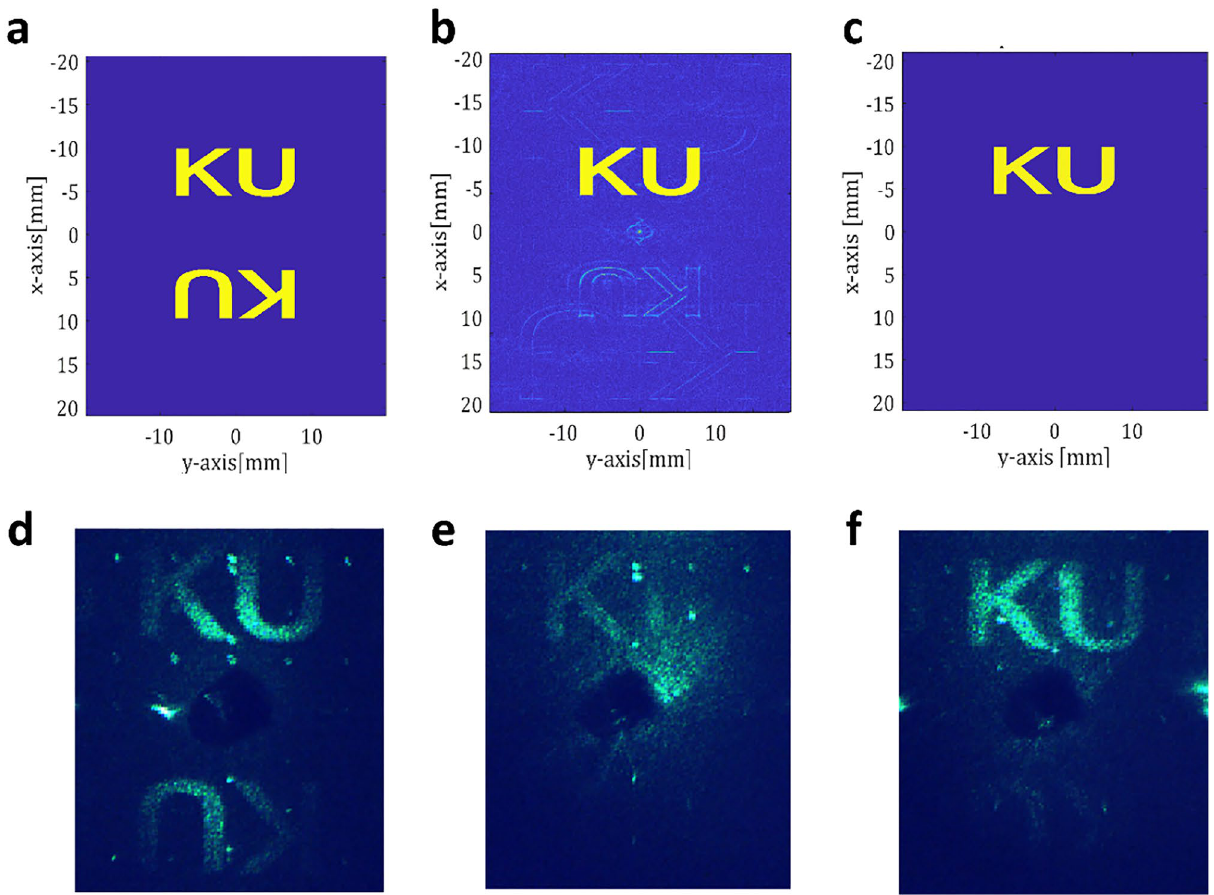
Figure 7. Numerical simulation ( a – c ) and experiment ( d – f ) for the optical Fourier transform of CGH: ( a , d ) the amplitude-only CGH ( b , e ) the phase-only CGH, and ( c , f ) the complex CGH. A DC noise rejection filter was used to distinctively observe conjugate noise